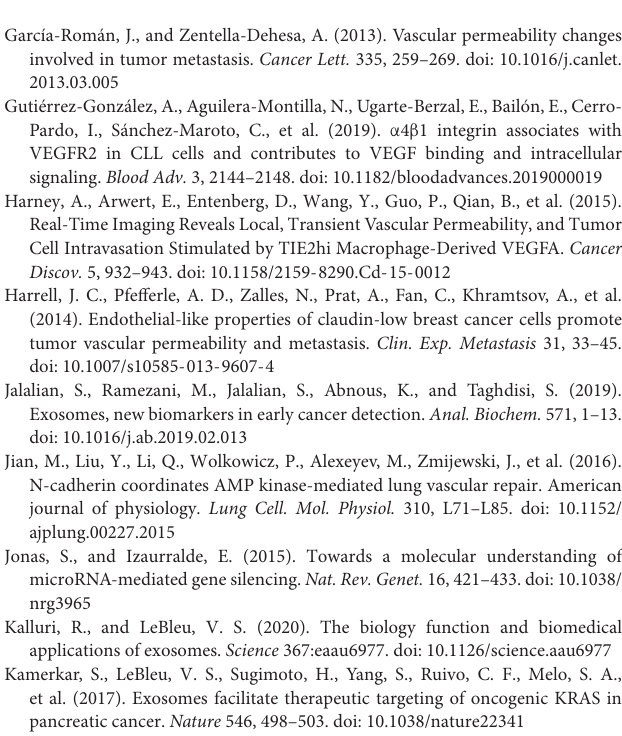
Supplementary Figure 1 | Supplemental results. (A) RT 2 profiler-PCR array gene expression analysis of the VEGF pathway of HUVEC cells treated with exosomes from 786-O and 786-O-SR cells. (B) The Table about the over-expressed and under-expressed proteins in 786-O-SR treatment group Compared with the 786-O treatment group. (C) Western blot analysis of E -cadherin expression. (D) The detection of transfection efficiency of miR-549a-3p/ miR-549a-5p mimics/inhibitors in HUVECs by RT-PCR and gel electrophoresis of PCR products analysis. (E) RT-PCR and western blotting analysis of HIF1 α expression. (F) The sequences of all primers. (G) The sequences of reverse transcription primers. (H) The sequences of miRNA mimics and inhibitors. (I) Western blot analysis of HIF1 α expression of exosomes from 786-O and 786-O-SR. (J) Western blot analysis of HIF1 α expression of 786-O and 786-O-SR treated by different media. ** P < 0.01, *** P < 0.001 according to two-tailed Student’s t